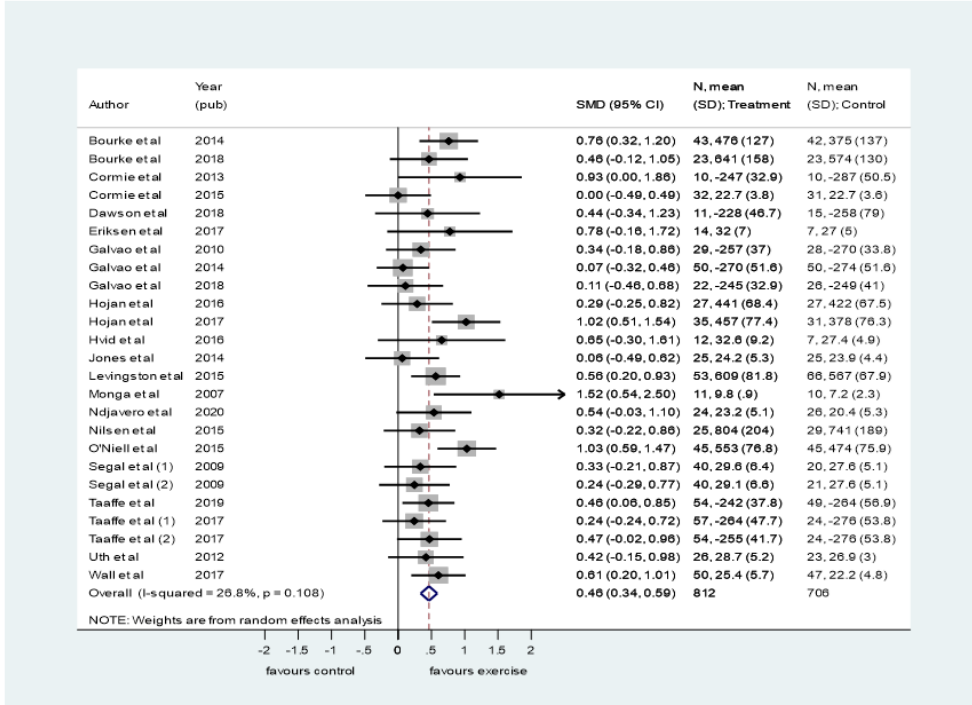
Figure 3. Pooled standard mean difference (SMD) on cardiovascular fitness comparing exercise in- terventions with usual care or control in men with prostate cancer. A random effects model of Der- Simonian and Laird, with estimate of heterogeneity from the Mantel – Haenszel model, was used. Supplementary Material File S5 provides the forest plots for the remaining